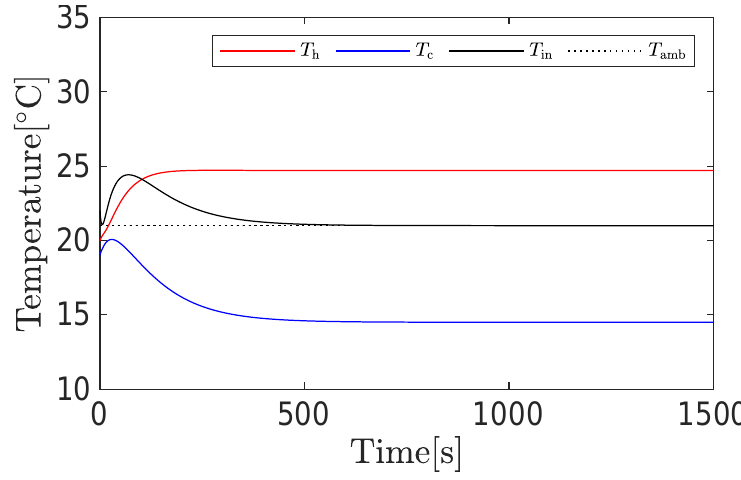
Figure 8. Temperature of T in , T amb , T h , T c